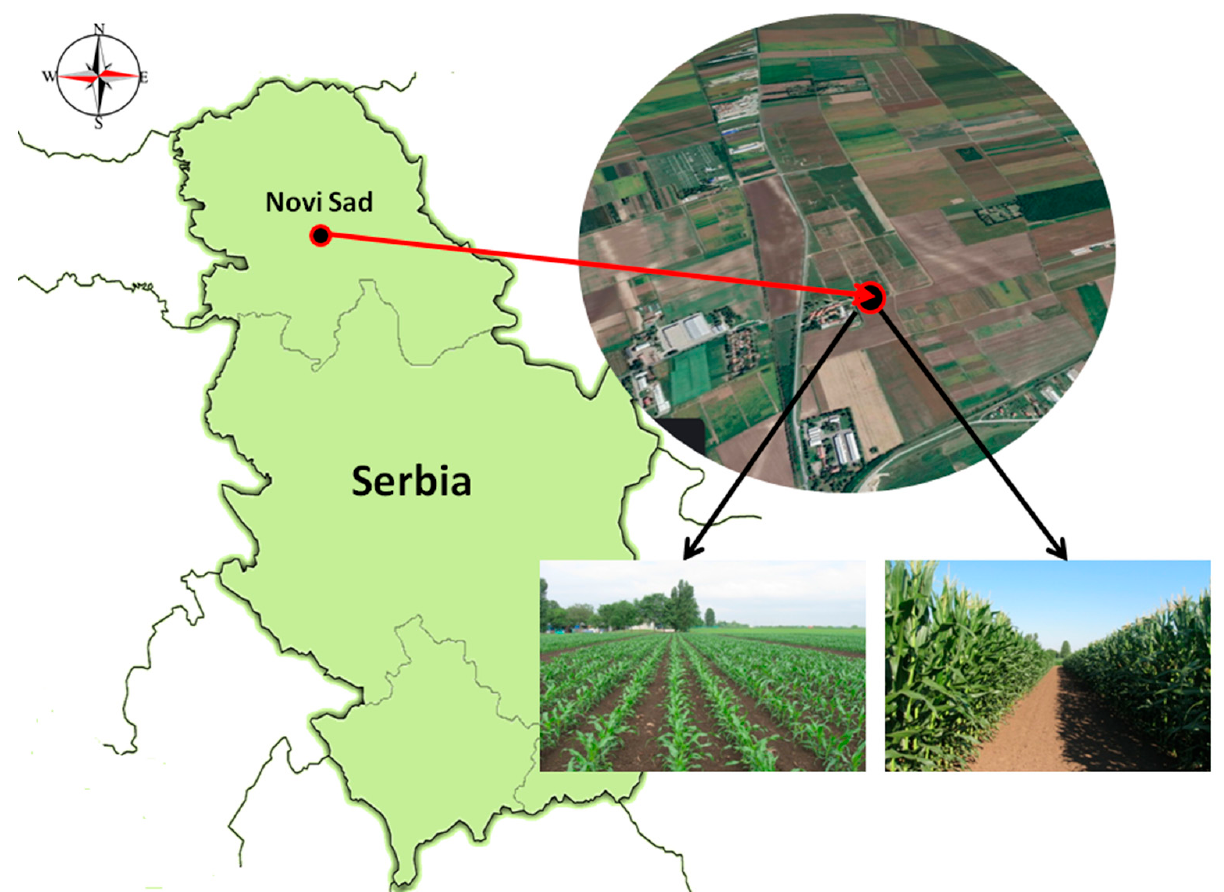
Figure 1. Location map and experimental field.